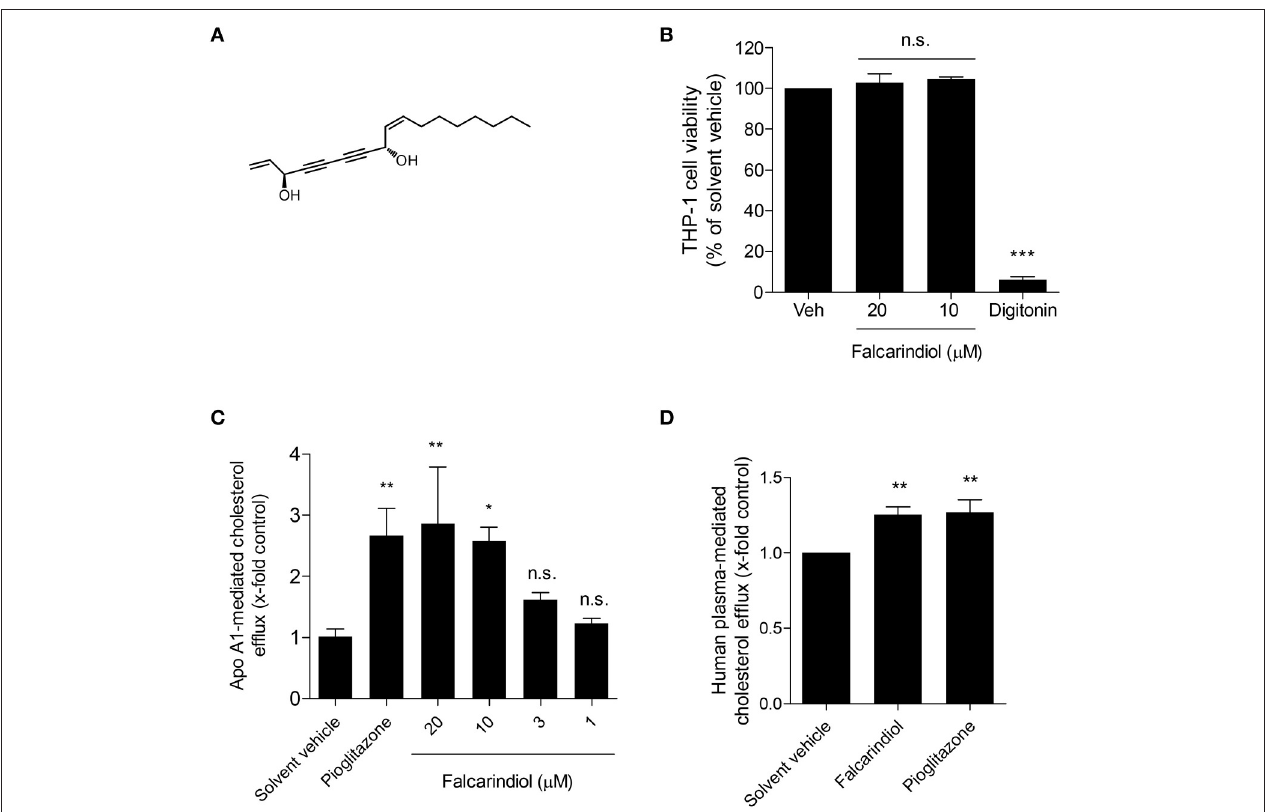
FIGURE 1 | Chemical structure of falcarindiol (A) , its effect on cell viability (B) , and cholesterol efflux in THP-1-derived macrophages (C,D) . (B) Differentiated THP-1 macrophages were incubated with solvent vehicle control (DMSO), 50 µ g/mL digitonin, or the indicated concentrations (10–20 µ M) of falcarindiol. After 24 h, the increased fluorescent signal from resazurin conversion was detected and calculated as the percentage of cell viability. (C,D) THP-1-derived macrophages were loaded with [ 3 H]-cholesterol together with the indicated treatments for 24 h. On the next day, macrophages were washed twice with pre-warmed PBS and incubated with the same compounds [solvent vehicle (DMSO), falcarindiol (1–20 µ M for apo A1-mediated cholesterol efflux, or 10 µ M for human plasma-mediated cholesterol efflux), or the PPAR γ agonist pioglitazone (10 µ M) as positive control] with or without 10 µ g/mL apo A1 (C) or 1% human plasma (D) dissolved in serum-free medium for 6 h. Extracellular as well as intracellular radioactivity were quantified with a scintillation counter. All values are means ± SD ( n = 3) and vs. solvent vehicle control (DMSO): * p < 0.05, ** p < 0.01, *** p < 0.001, n.s, not significant